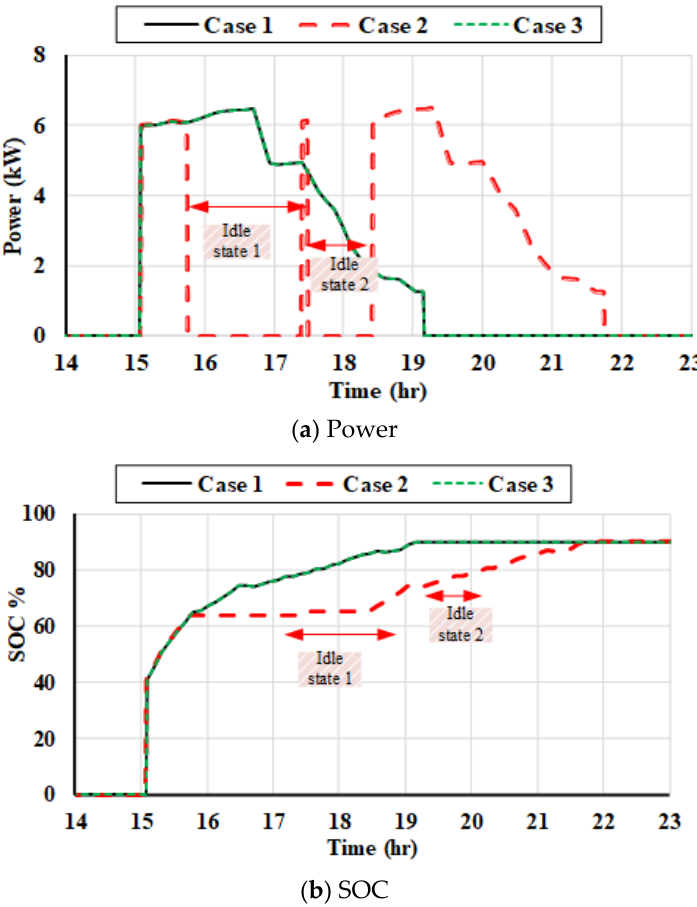
Figure 19. EV# k charging behavior at different case studies.